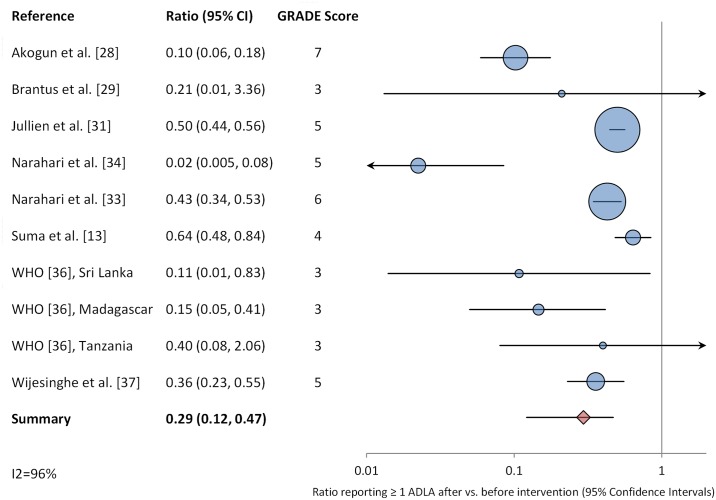
Meta-analysis examining the association between hygiene-based lymphedema management and the percentage of patients reporting at least one episode of ADLA during a specific time interval.